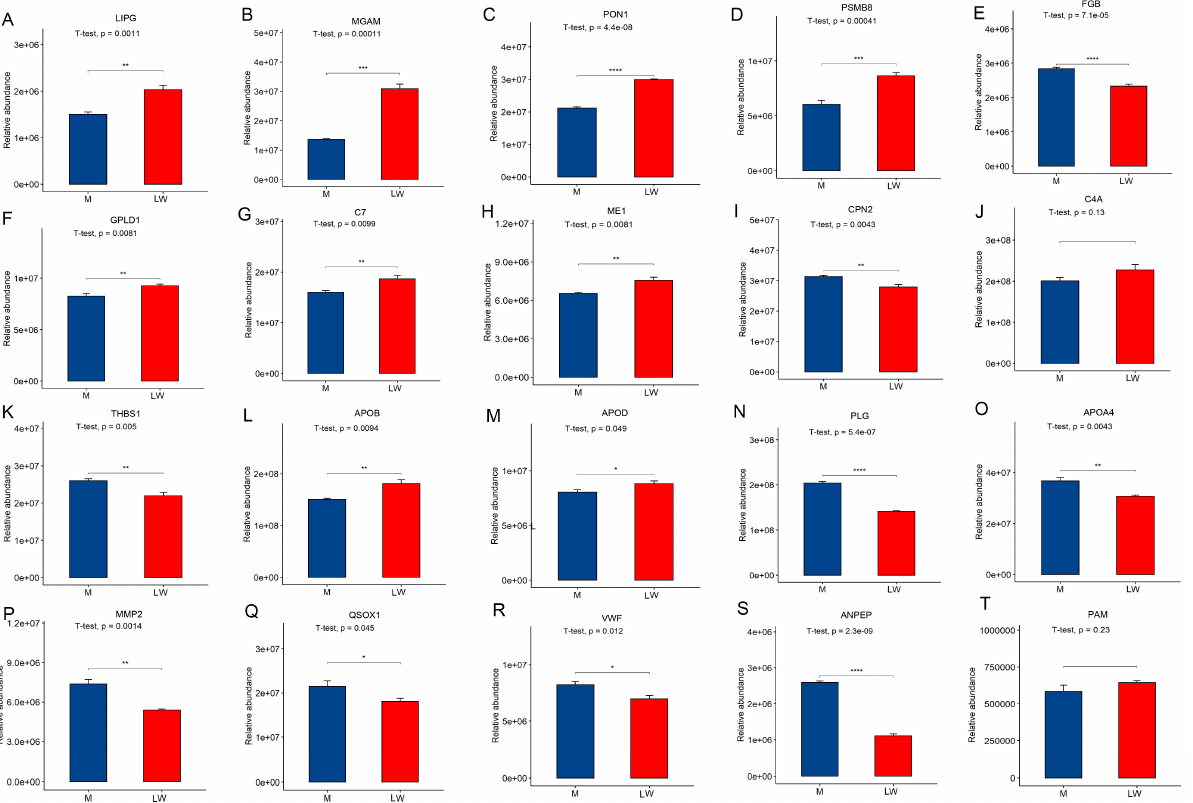
Figure 10. Quantification validation of proteins by parallel reaction monitoring (PRM). (A–T) Quan- titative results of PRM for some differential proteins. p -value ≥ 0.05: no marks; p -value ≤ 0.05: *; p -value ≤ 0.01: **; p -value ≤ 0.001: ***; p -value ≤ 0.0001: